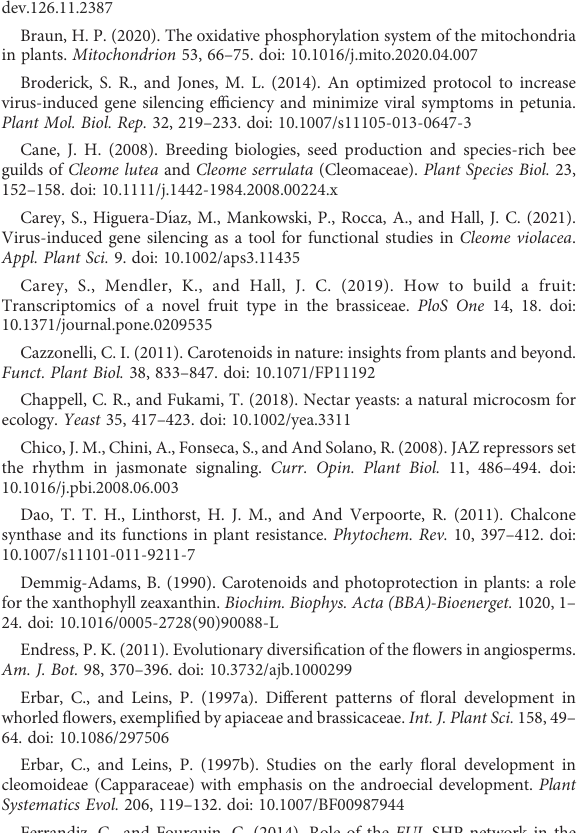
fi nger and helix-loop-helix domains. Development 126, 2387 – 2396. doi: 10.1242/